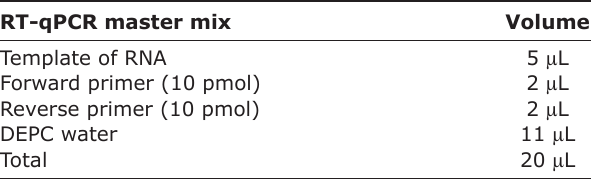
Table-2: The components of the master mix reaction of